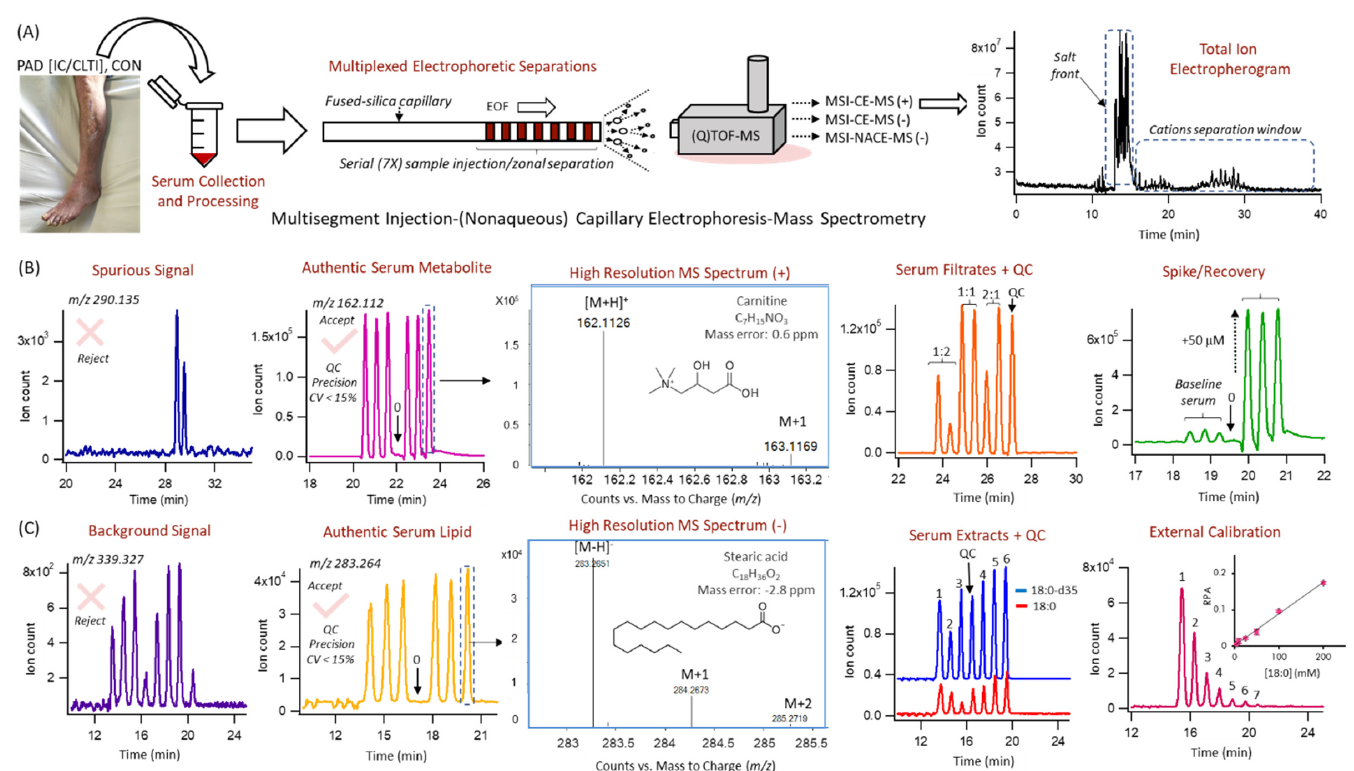
Figure 1. ( A ) Nontargeted metabolite profiling of serum samples from PAD patients using MSI–(NA)CE–MS under three di ff erent configurations, where the black trace depicts a total electropherogram using aqueous BGE conditions with positive mode detection. This multiplexed separation method relies on a serial injection of 6 serum samples and a quality control (QC) within each run to enhance sample throughput and data fidelity when using temporal signal pattern recognition. A rigorous data ‐ filtering process allows for the reliable authentication of metabolites based on their accurate mass ( m/z ), which are measured in 6 replicate serum samples with acceptable precision (CV < 15%) with no background signal in blank (0) as shown for ( B ) carnitine and ( C ) stearic acid (18:0) under positive and negative ion mode detection, respectively. Various serial injection configurations are illustrated, such as a replicate injection of QC samples with a blank extract to filter out spurious and background signals in ESI–MS, the assessment of technical precision and potential sample carry ‐ over for authentic serum metabolites, a randomized analysis of 6 serum samples from individual PAD patients along with a QC, a spike ‐ recovery study to evaluate accuracy and confirm the identity based on co ‐ migration, and a 7 ‐ point calibration curve for serum metabolite quantification.